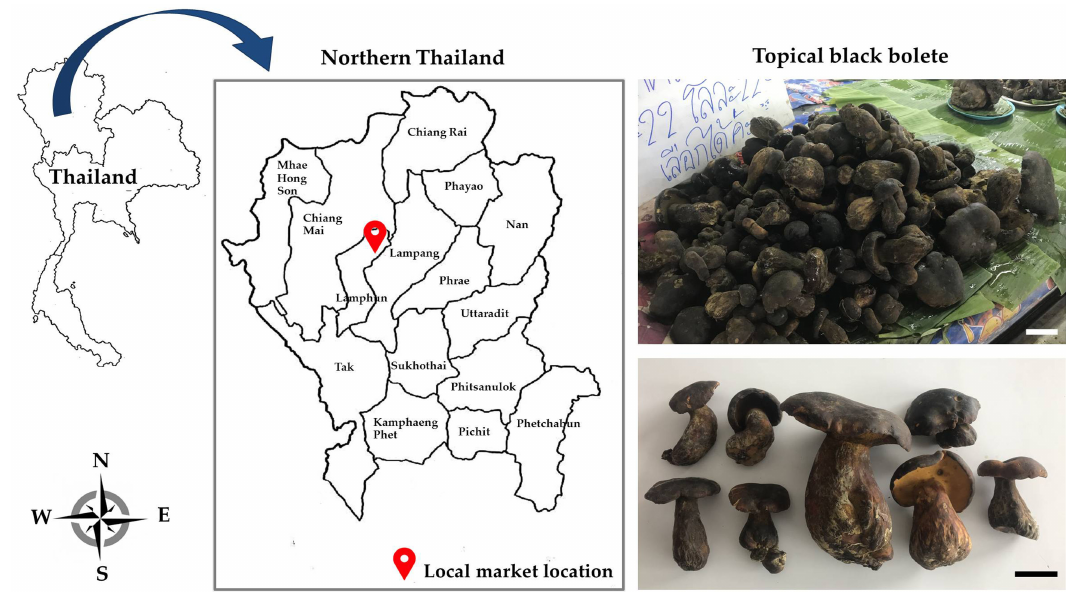
Figure 1. Local market location and fresh fruiting bodies of the tropical black bolete. Scale bar = 5